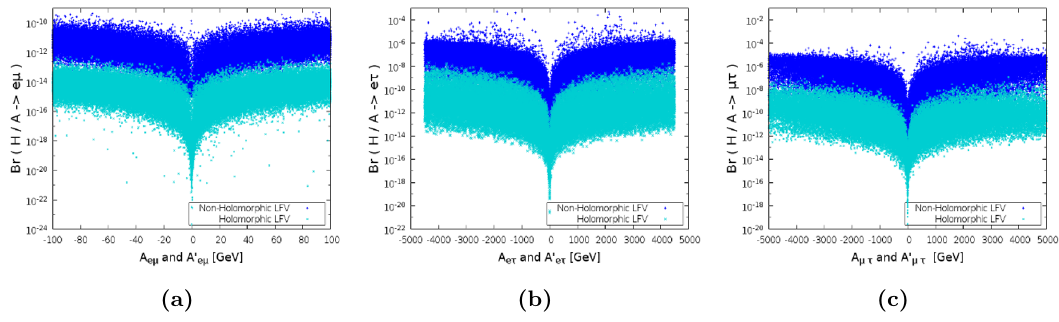
0 ) Figure 8. Br ( H=A e(cid:22) ) as a function of A ( e(cid:28) ) as a function e(cid:22) in the left most side, Br ( H=A ! ! 0 ) 0 ) of A ( (cid:22)(cid:28) ) as a function of A ( e(cid:28) in the middle and Br ( H=A (cid:22)(cid:28) in the right side are shown with ! m H ; m A = 1 : 5 TeV. Color coding is same as explained in (cid:12)gure